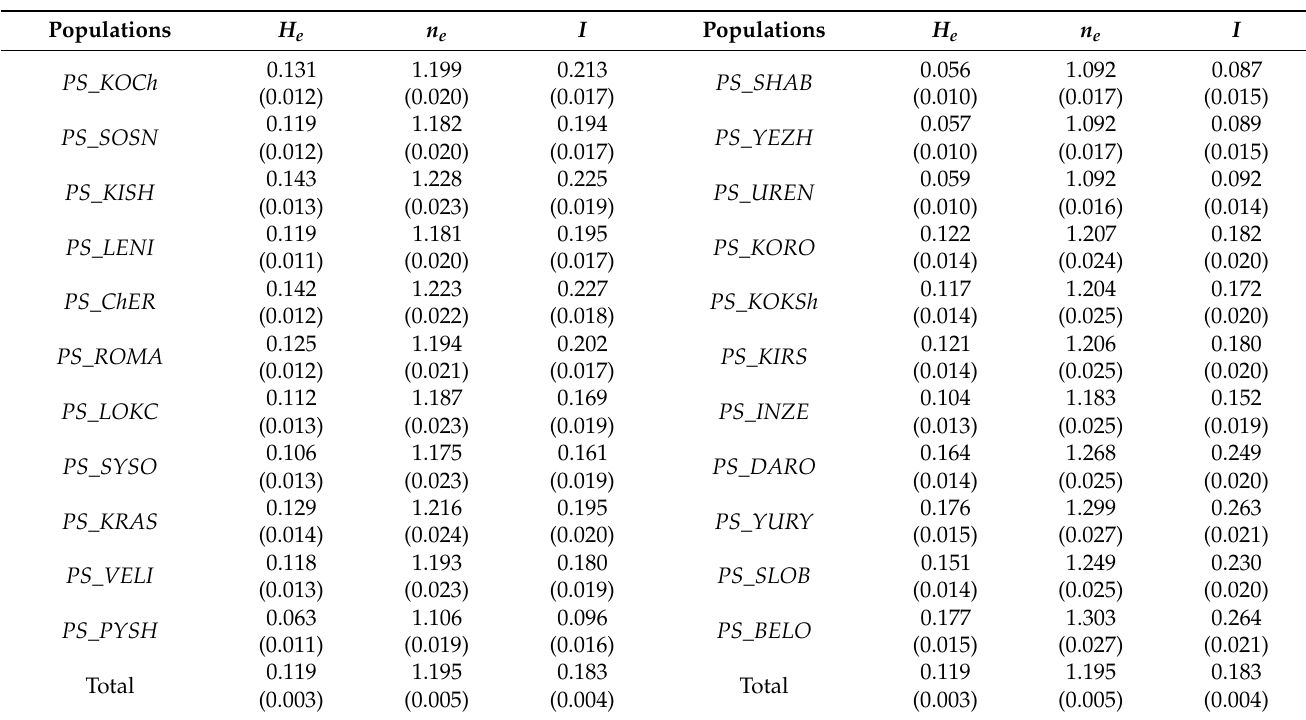
Table 2. Genetic diversity of the studied populations of P. sylvestris